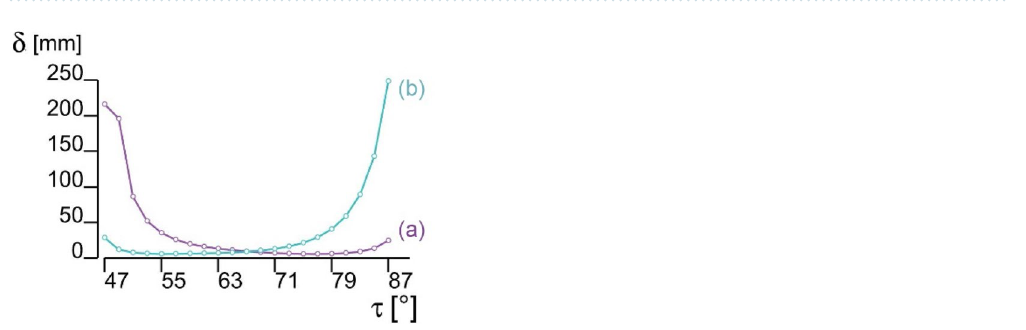
Figure 13. Deflection of the floor with varying angles [Case (a) and (b) are as in Fig. 12].